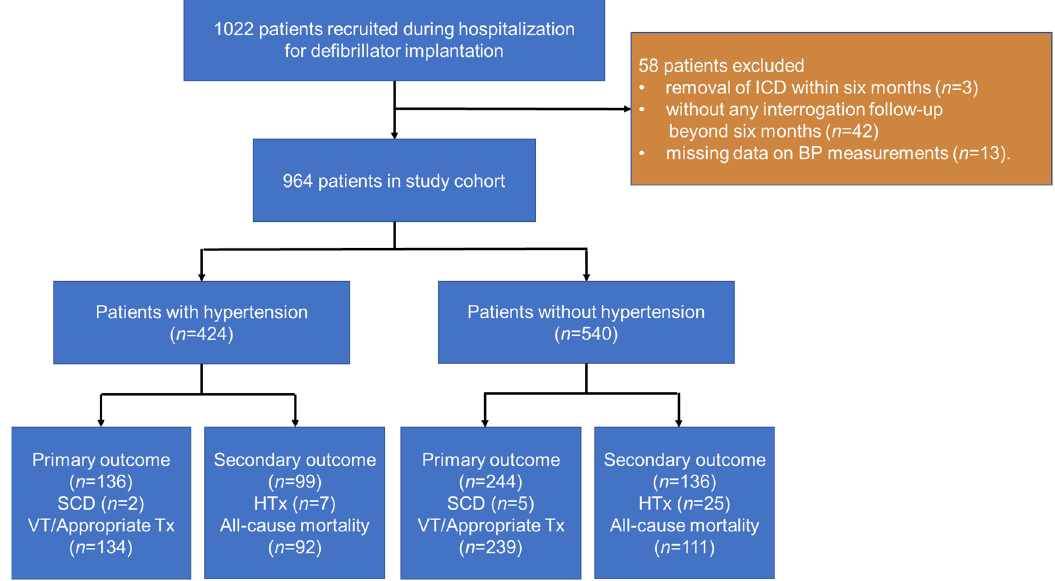
Figure 1. Flow chart depicts patients included in the study and outcomes. Appropriate Tx, appro- priate ICD therapy; BP, blood pressure; HTx, heart transplantation; ICD, implantable cardioverter-